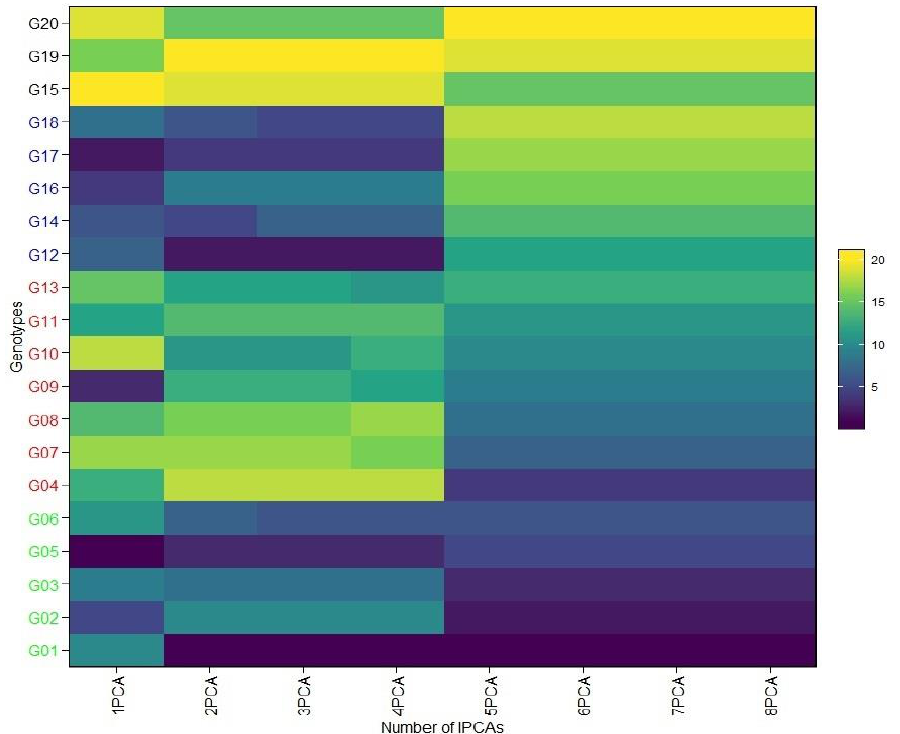
Figure 6. Heatmap showing the ranking of the 20 wheat genotypes in relation to the number of IPCAs used in the weighted average of the absolute scores for the BLUPs of the genotype vs. environment interaction (WAASB) estimation.